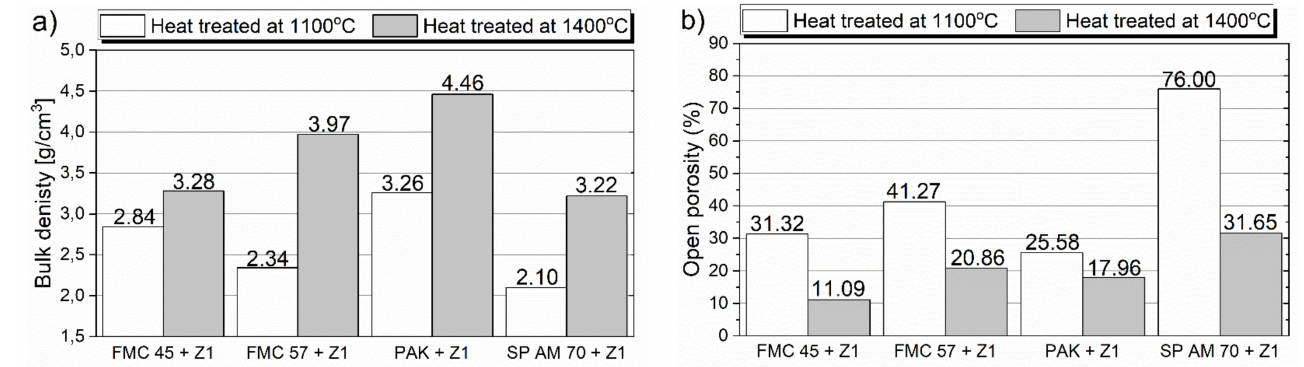
Figure 6. Bulk density ( a ) and open porosity ( b ) of samples after pellet corrosion test at 1100 ◦ C and 1400 ◦